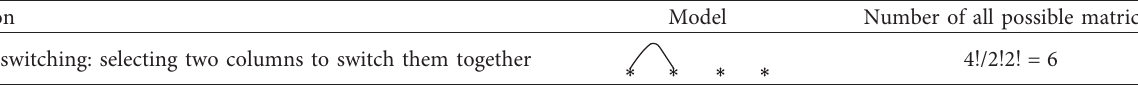
Table 2: One switching operation.